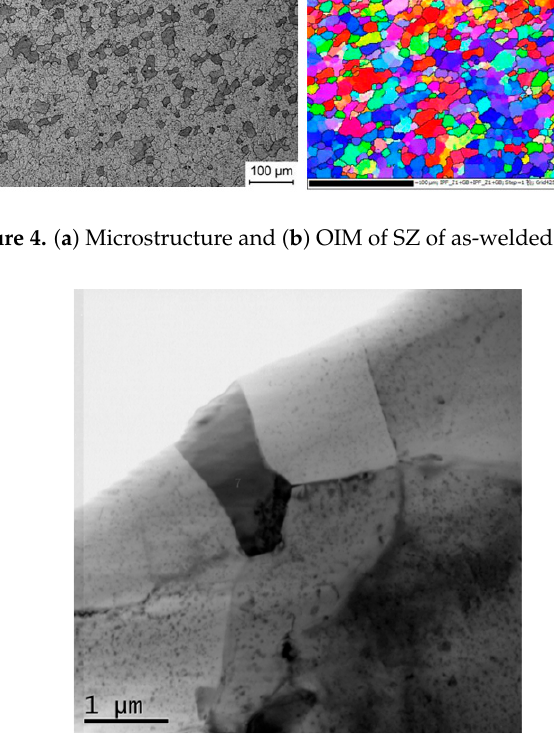
Figure 5. TEM of the weld nugget.